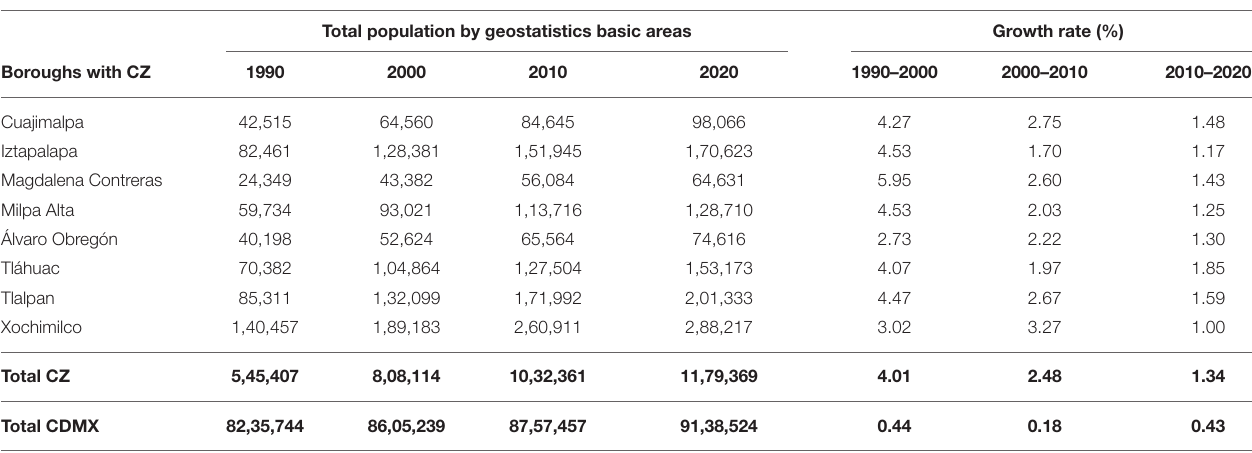
TABLE 1 | The conservation zone: demographic growth by boroughs, 1990–2000. Total population by geostatistics basic areas Growth rate